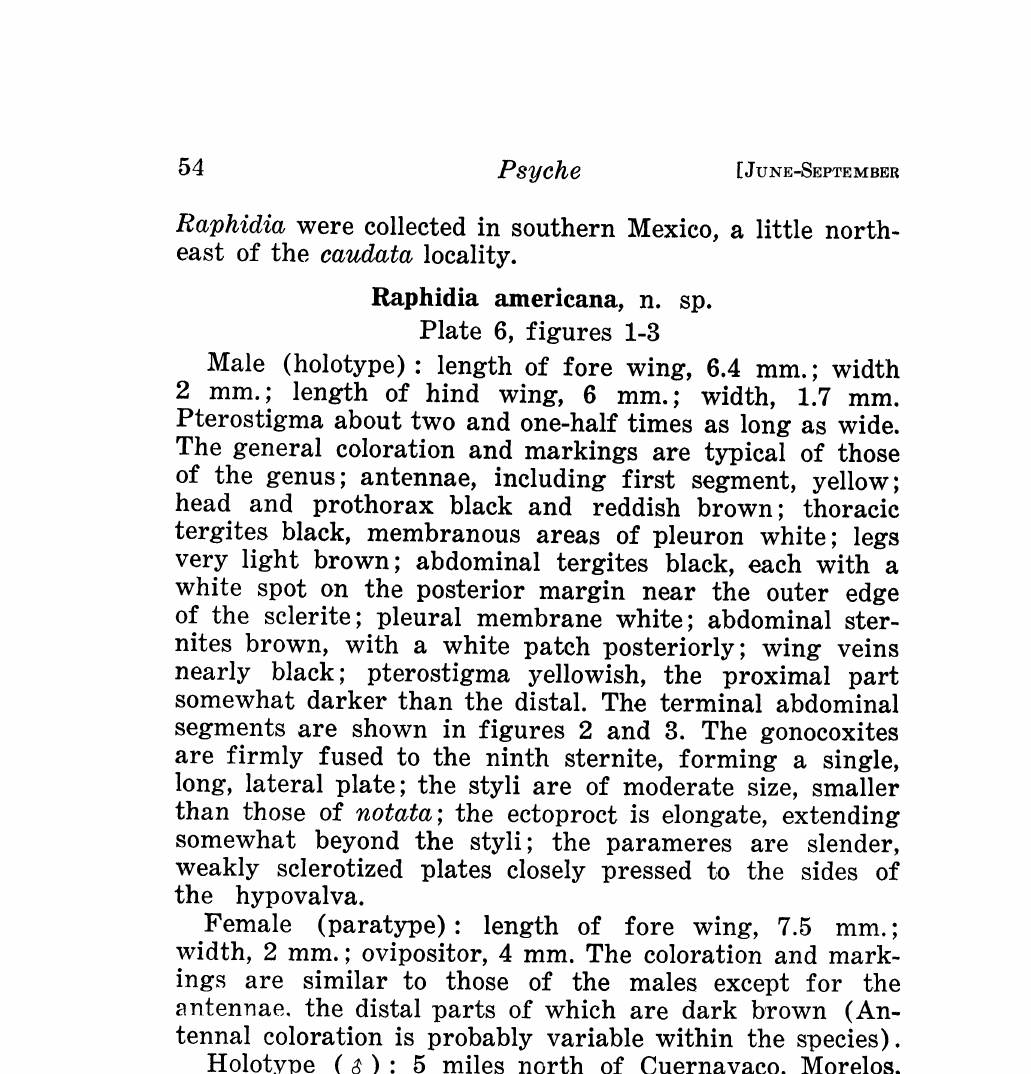
Fig. 5. Part of an antenna.. Fig. 6. A single antennal segment. Fig. 7. Terminal abdominal segments. Lettering: be, basal